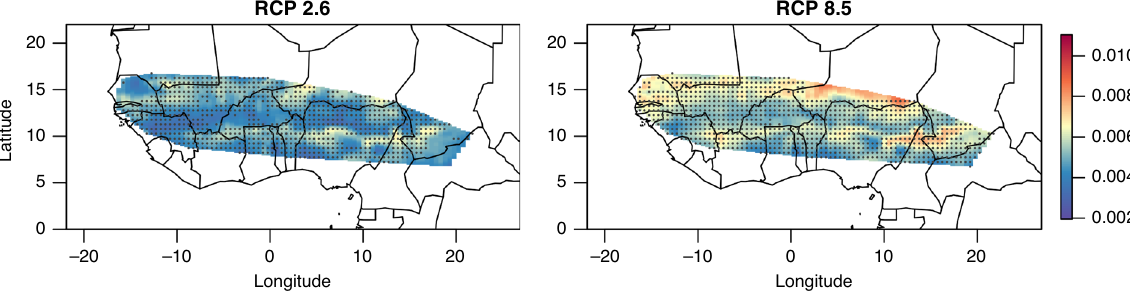
Fig. 2 Pearl millet genomic vulnerability to climate change at the 2050 horizon. Genomic vulnerabilities in West Africa were estimated based on projections for two scenarios of gas concentration pathways RCP2.6 and RCP8.5. The color scale refers to the mean value of genomic vulnerability estimated for 17 climate model projections. Stippling identi fi es areas where the magnitude of the mean genomic vulnerability is more than twice the SD (i.e., coef fi cient of variation <50%), identifying regions where mean genomic vulnerability estimated using multi-model climate projections is high compared to the inter-model estimates of